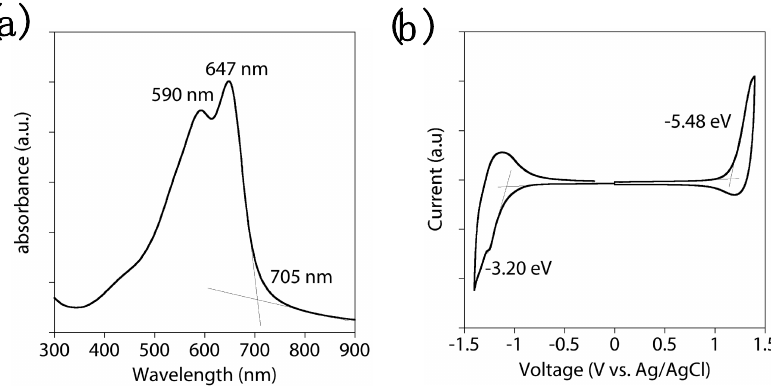
Figure 2. ( a ) UV-vis absorption spectrum of PTzTBI in thin film. ( b ) Cyclic voltammgram of PTzTBI.